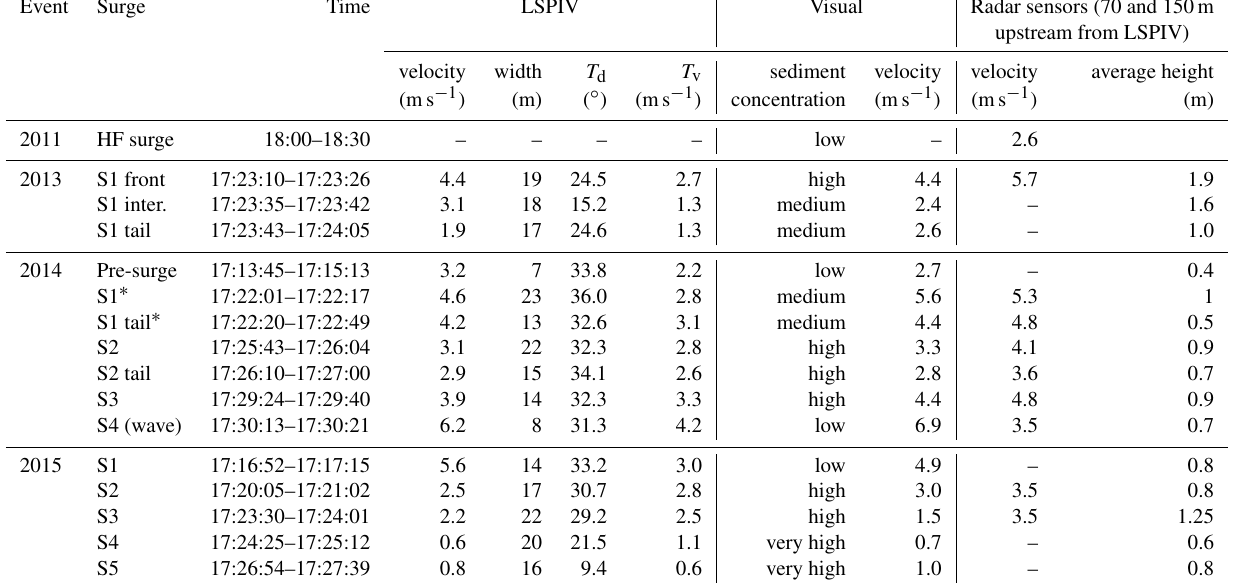
Table 2. Results of averaged LSPIV measurements, visual feature measurements on orthorectifed images, and radar sensors (70–150m upstream from the LSPIV section) for identifiable surges in 2011, 2013, 2014, and 2015 (no events occurred in 2012).